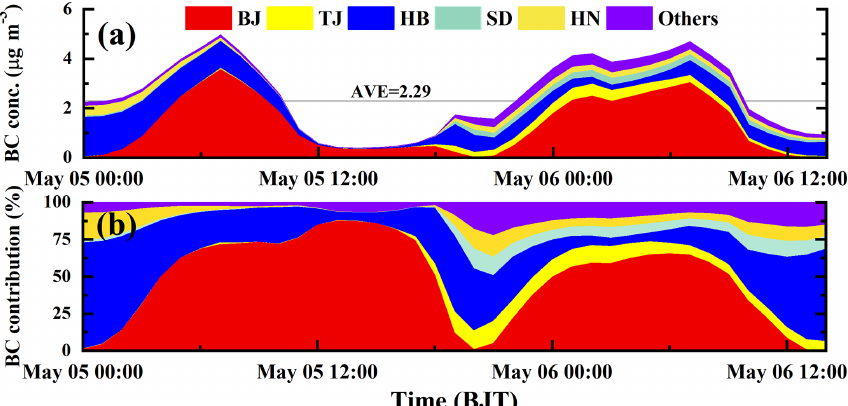
Figure 5. (a) BC concentration and (b) contribution rate of each source region to BC in BJ during the pollution episode. The legend refers to the regions shown in Fig. 1.